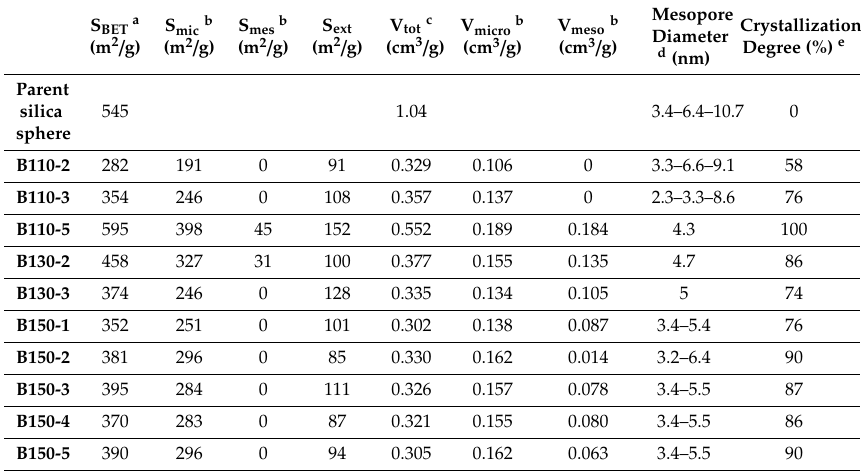
Table 2. Textural properties of the calcined materials synthetized by pseudomorphic transformation and of the parent amorphous silica spheres. Silicalite-1 beads are presented as a function of their temperature and duration synthesis (B-T( ◦